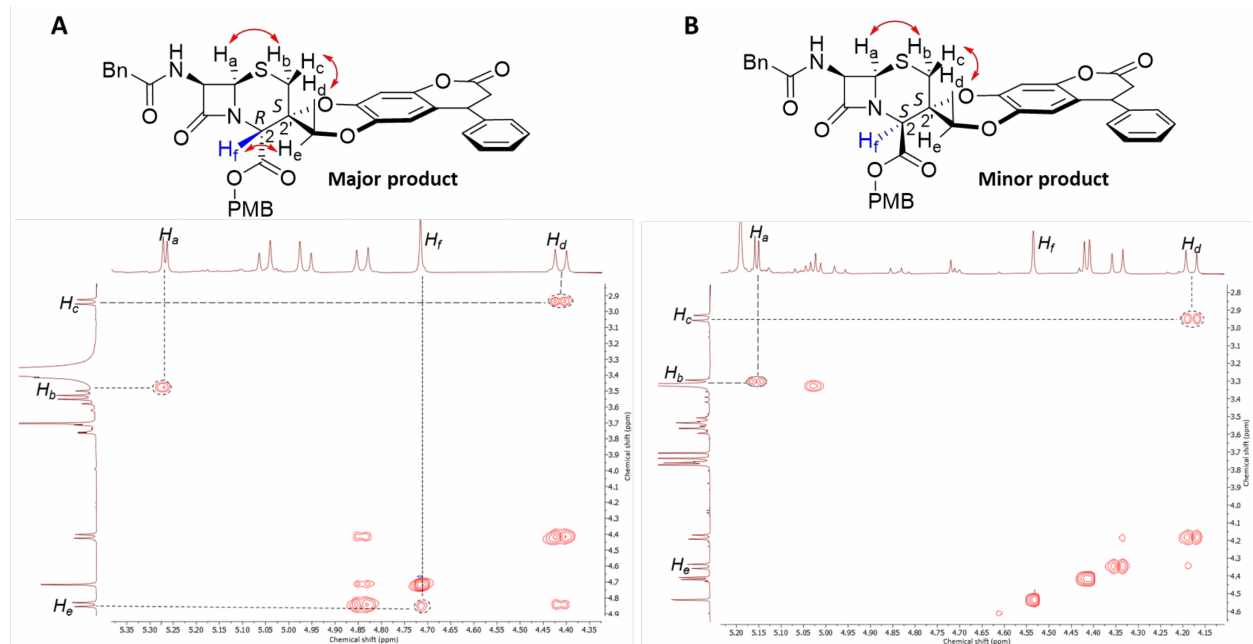
Figure 3. NOSEY spectra of ( A ) the major diastereomer 15 and ( B ) the minor